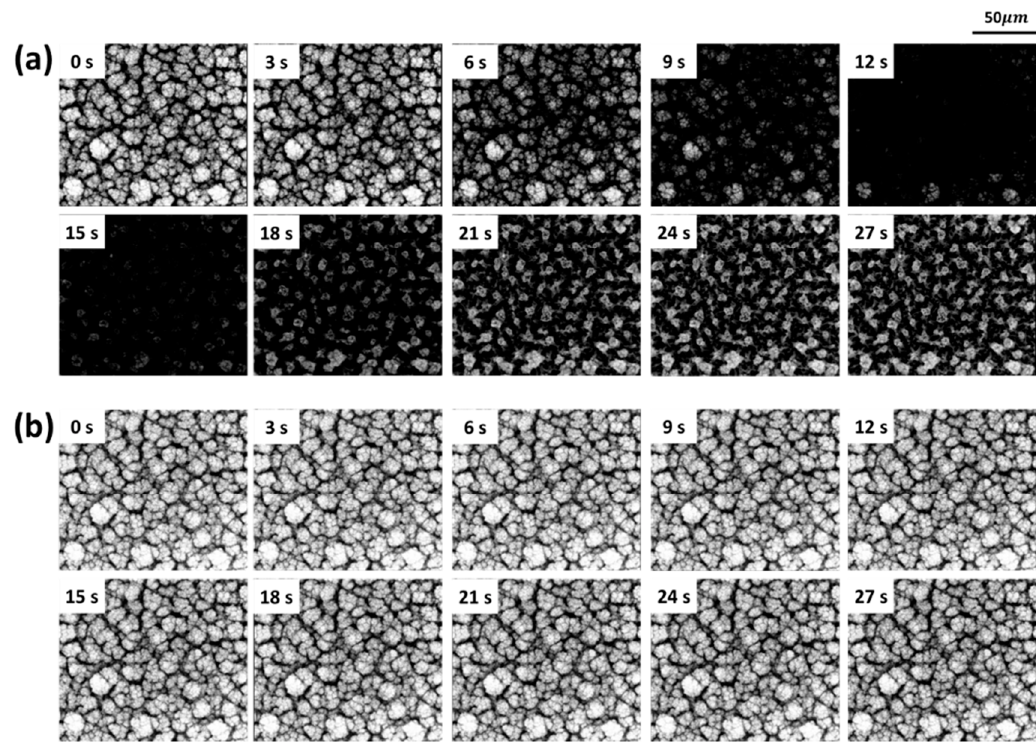
Figure 3. Top view of the water condensation process in E-SEM. ( a ) Case of bare porous SnO 2 and ( b ) case of PFOTS coated porous SnO 2 . Temperature of the sample holder is maintained at 4 °C. Pressure is regulated with water vapor from 400 Pa to 800 Pa in the E-SEM.